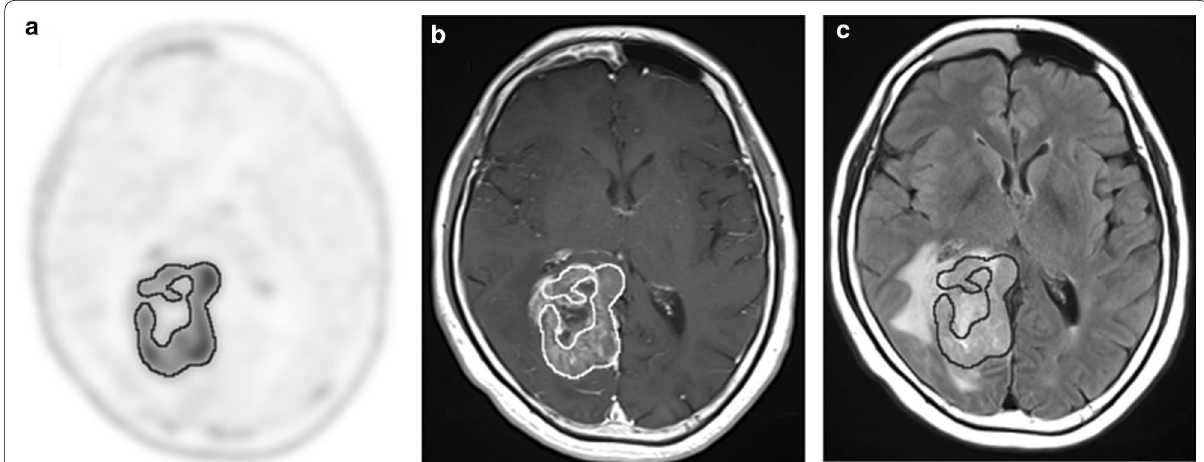
Fig. 1 Radiologic images of a 60-year-old female with newly diagnosed glioblastoma. Transverse 4DST PET image a shows inhomogeneous uptake in the right occipital lobe (SUVmax 5.36, T/N ratio 13.74, PTV 44.58 cm 3 ). Transverse T1-weighted MRI with Gd enhancement b shows = = = inhomogeneously enhanced lesion in tumor (GdV 48.28 cm 3 ). Region of interest shows proliferation area drawn on 4DST PET image from a. The = proliferation area on 4DST PET image and Gd enhancement area on MRI differed very slightly. The hyperintense area identified on transverse FLAIR MRI c is larger than the proliferation area on 4DST PET image (FLAIRV 137.52 cm 3 =